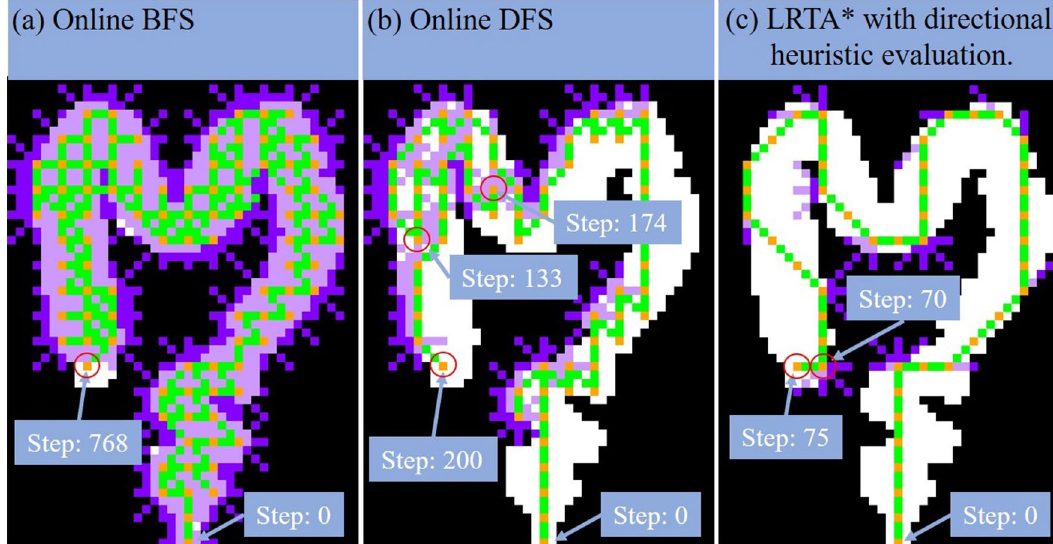
Figure 4. The trajectory simulation in synthetic colon with ( a ) online BFS ( b ) online DFS ( c ) LRTA* method. The taken steps for online BFS, online DFS and LRTA* are 768, 200 and 75, respectively. The non-passable states and the passable states are represented in black and white, respectively. When the algorithm starts to explore, the state in each iteration and the trajectory between states are represented in orange and green, respectively. If the non-passable state is visited, the trajectory is shown in